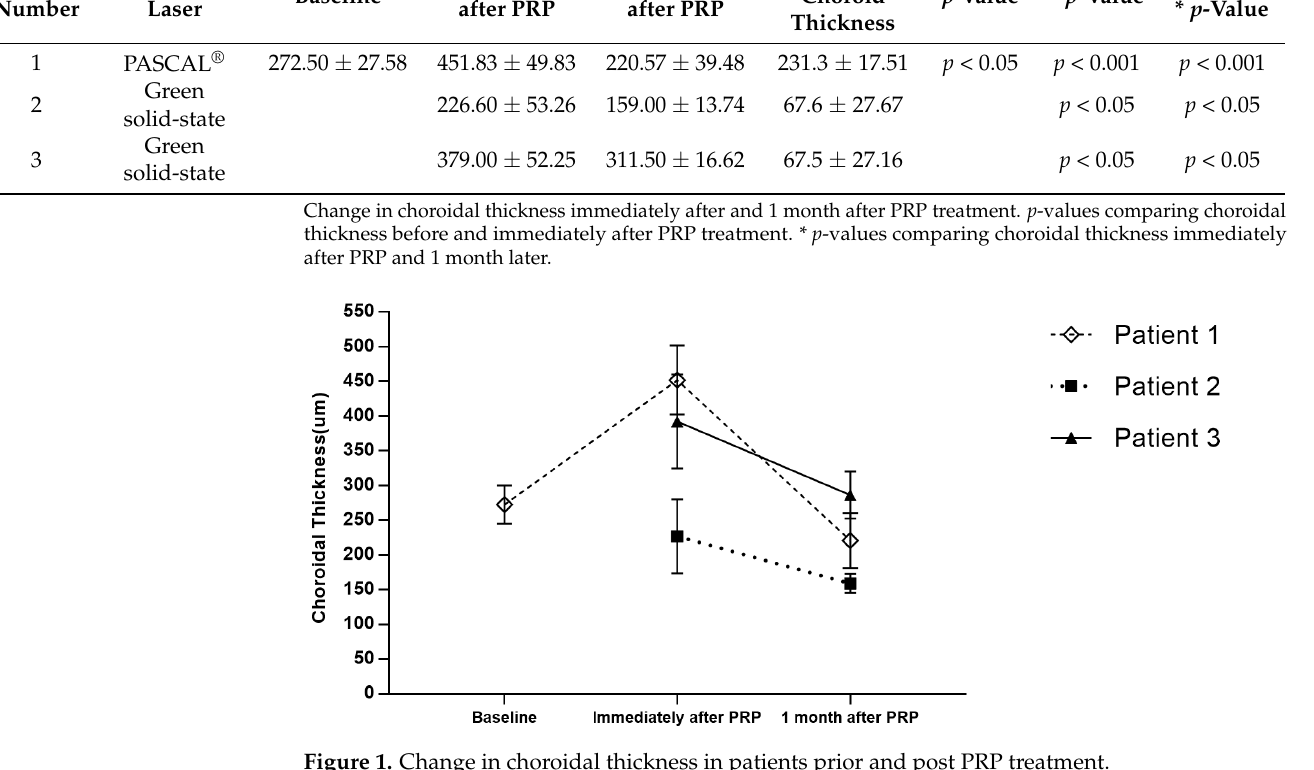
Table 2. Measured choroidal thickness before and after different types of PRP treatment.